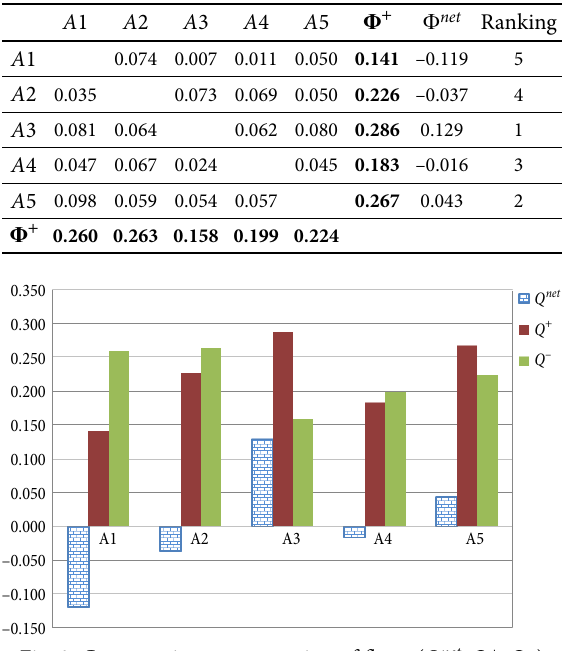
Fig. 3. Comparative representation of flows ( Q net , F + , F –